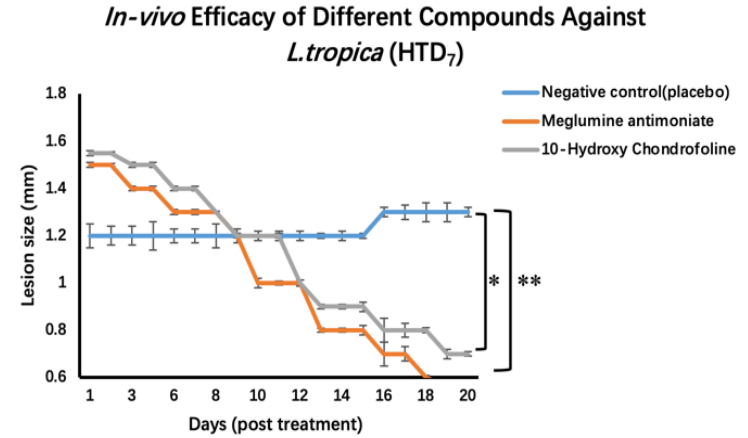
Figure 6. In vivo efficacy of 10-hydroxy chondrofoline in an experimental model of CL. Data are represented as mean ± standard deviation ( n = 6). Statistically significant differences are given as ** represents p < 0.002 and * p = 0.002.